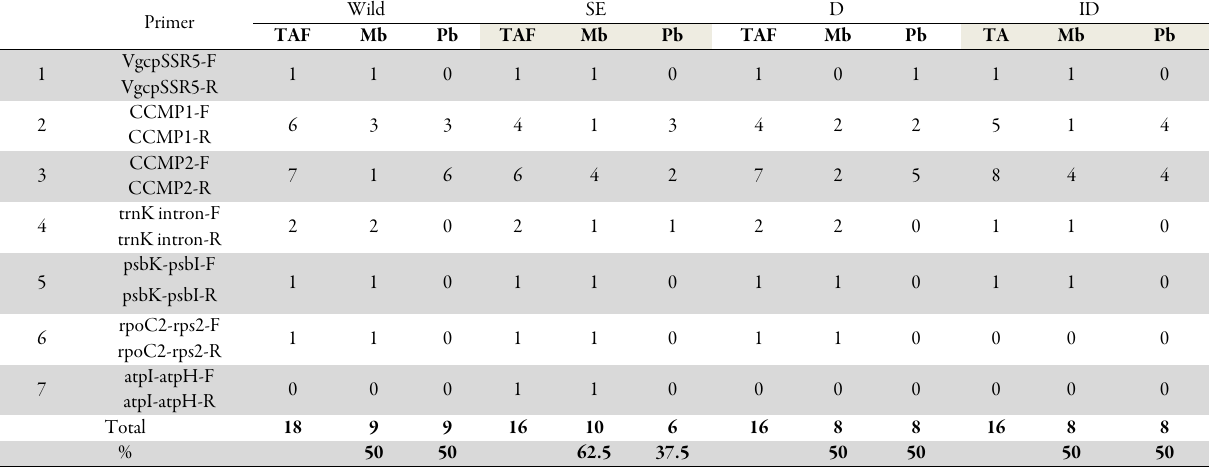
Table 3. cpSSR analysis within wild plants and in vitro regenerated plant groups (W= Wild, SE=somatic embryogenesis, D= direct, ID=